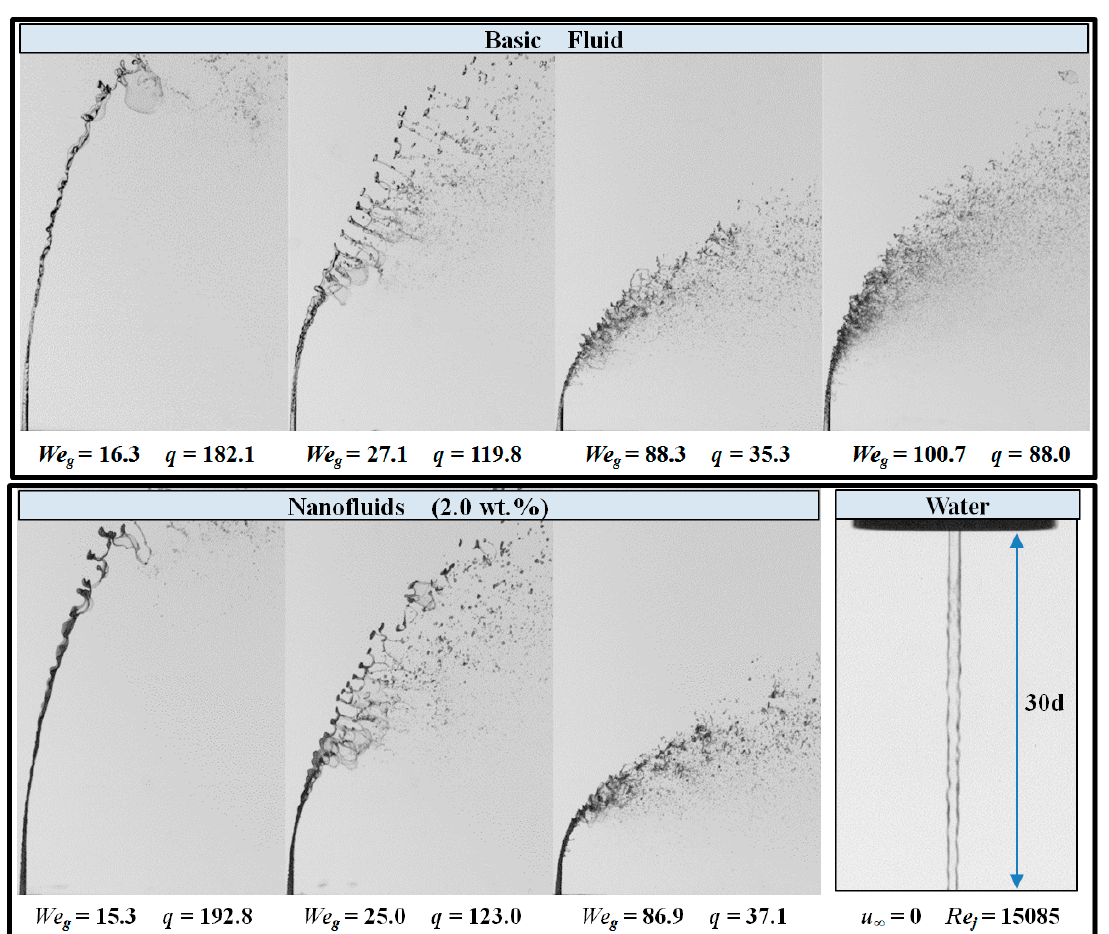
Figure 8. Transient shadowgraphs of transverse injection.